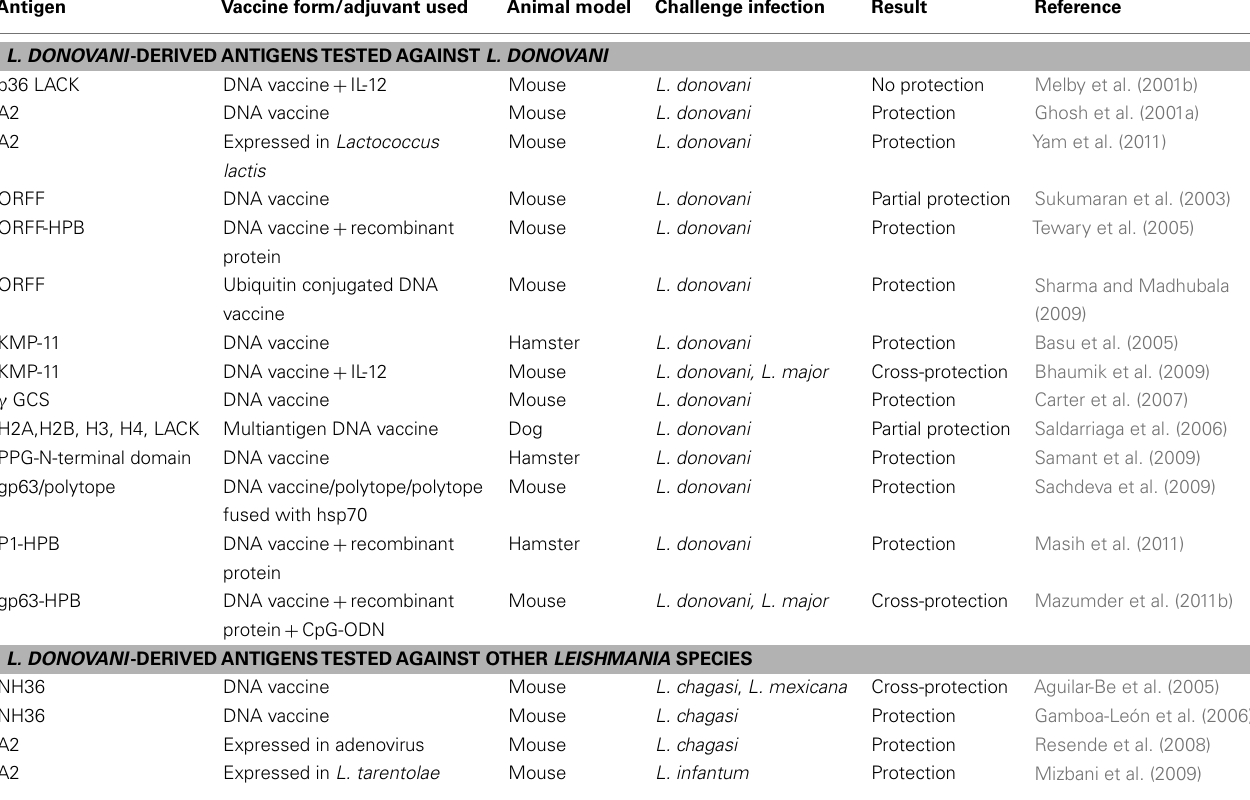
Table 2 |Third generation vaccine candidates for L. donovani